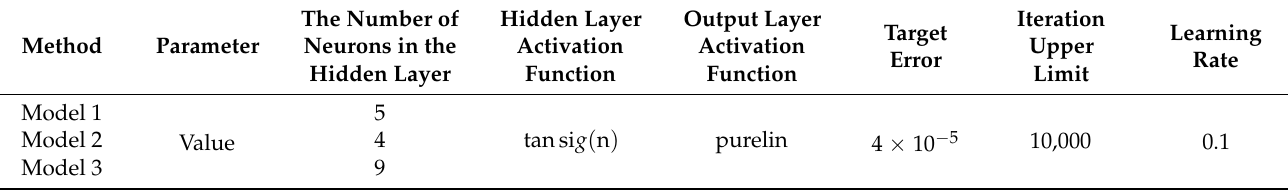
Figure 30. Neural network model diagram of tire vertical force estimation. Table 3. BP neural network model